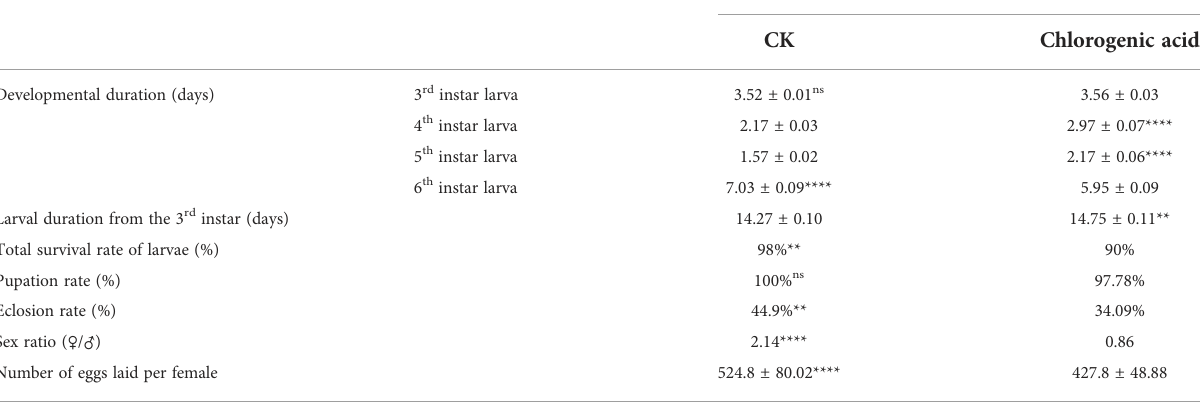
Data in the table are mean ± SE. Signi fi cance level(t-test):**p<0.01, ****p<0.0001, ns: not signi fi